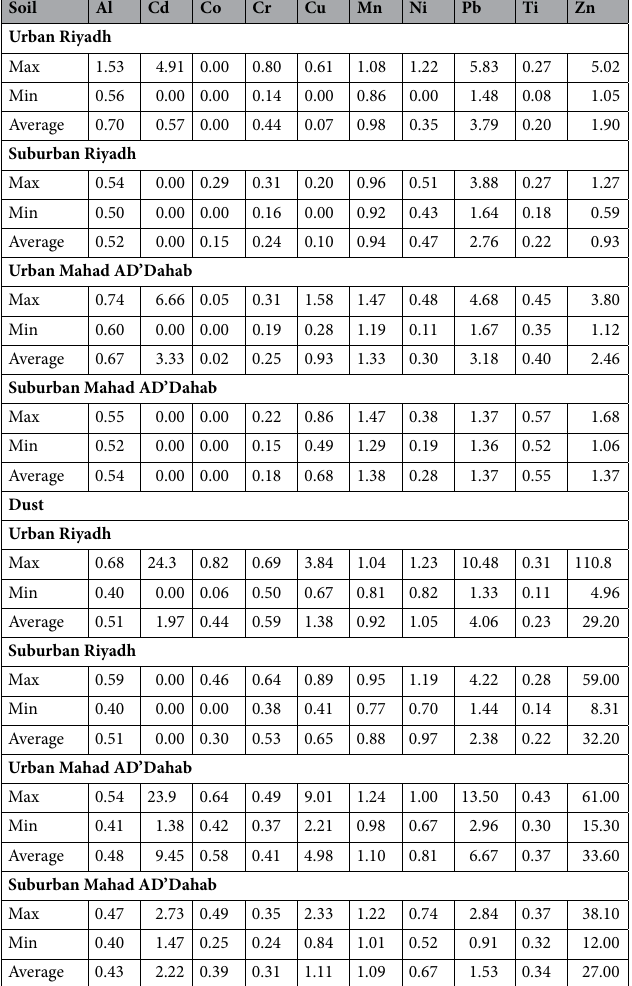
Table 5. The calculated data of the enrichment factor (EF) for heavy metals of soil and dust